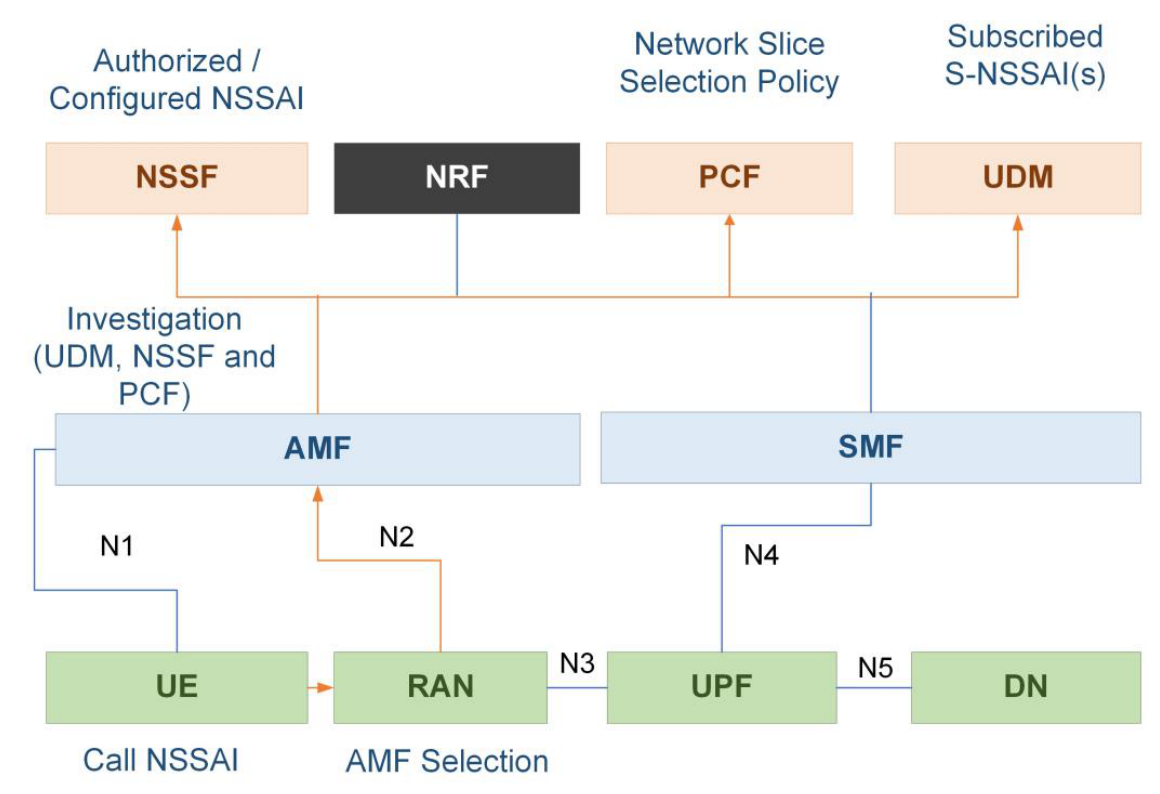
Figure 8. The 5G network SBA PDU session establishment. Table 5. Summary of 5G NS